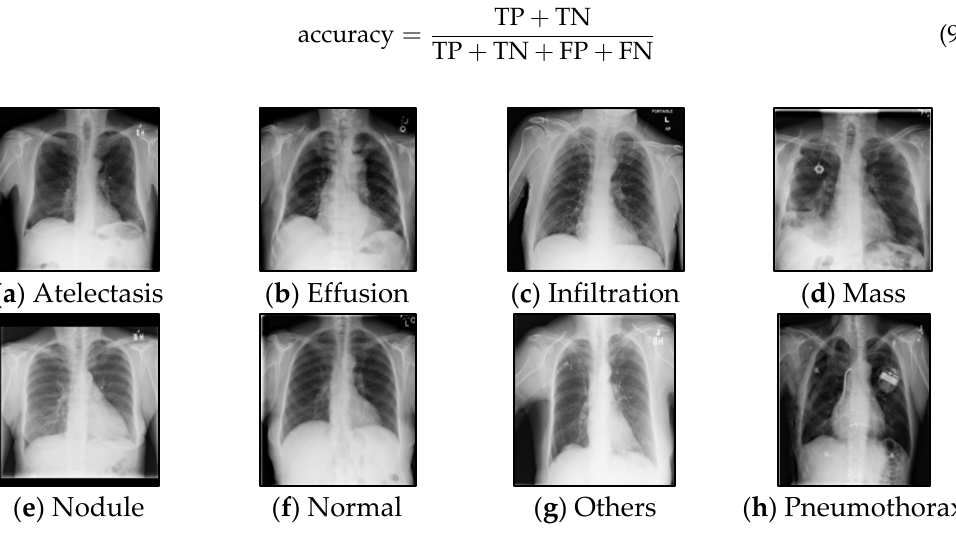
Figure 2. The chest X-ray sample images.